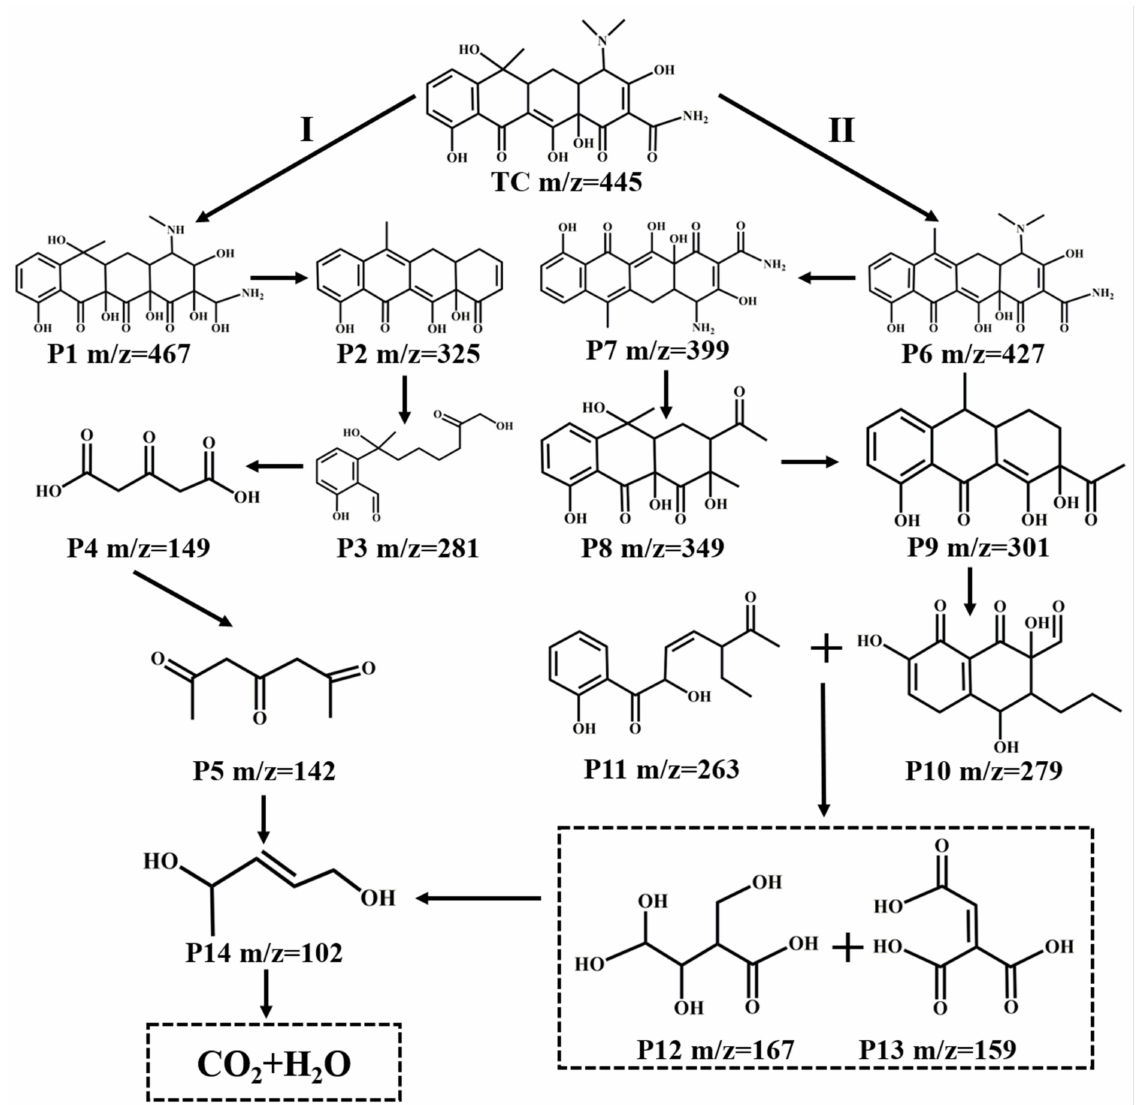
Figure 17. Possible pathways for TC PEC degradation under visible–light